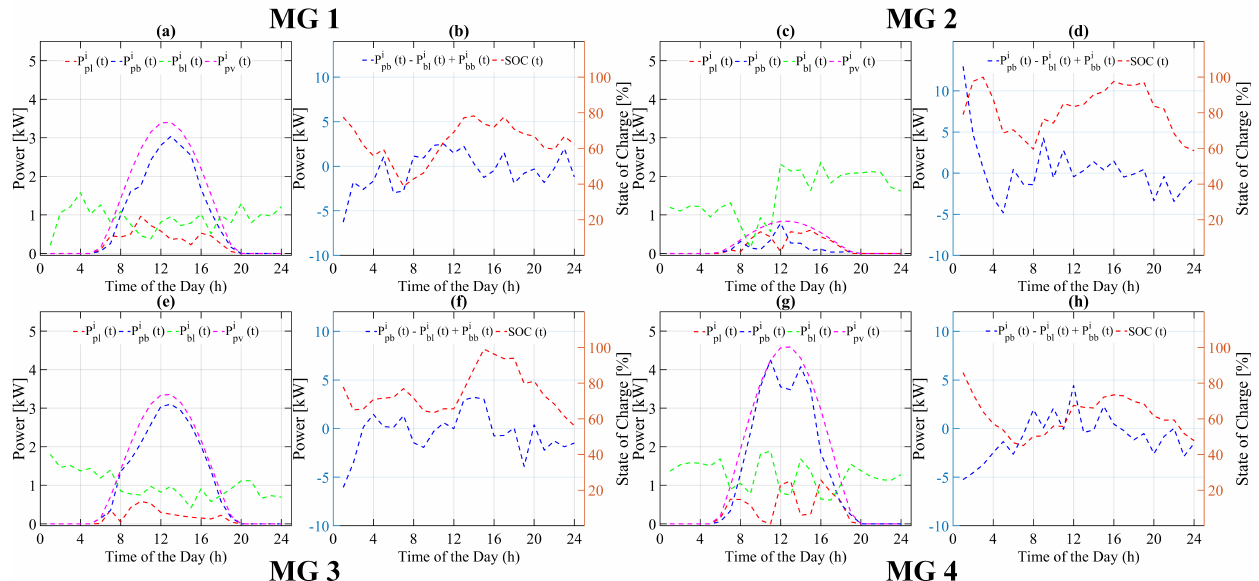
Figure 13. Power flow of various system variable of each microgrid using proposed optimiza- tion based energy management strategy for case D. ( a , c , e , g ) Power flow of PV, battery and Load, ( b , d , f , h ) Battery charging/discharging and state of charge. Table 3. State of charge (SOC) (%) of each microgrid at end of time cycle ( t = T ).